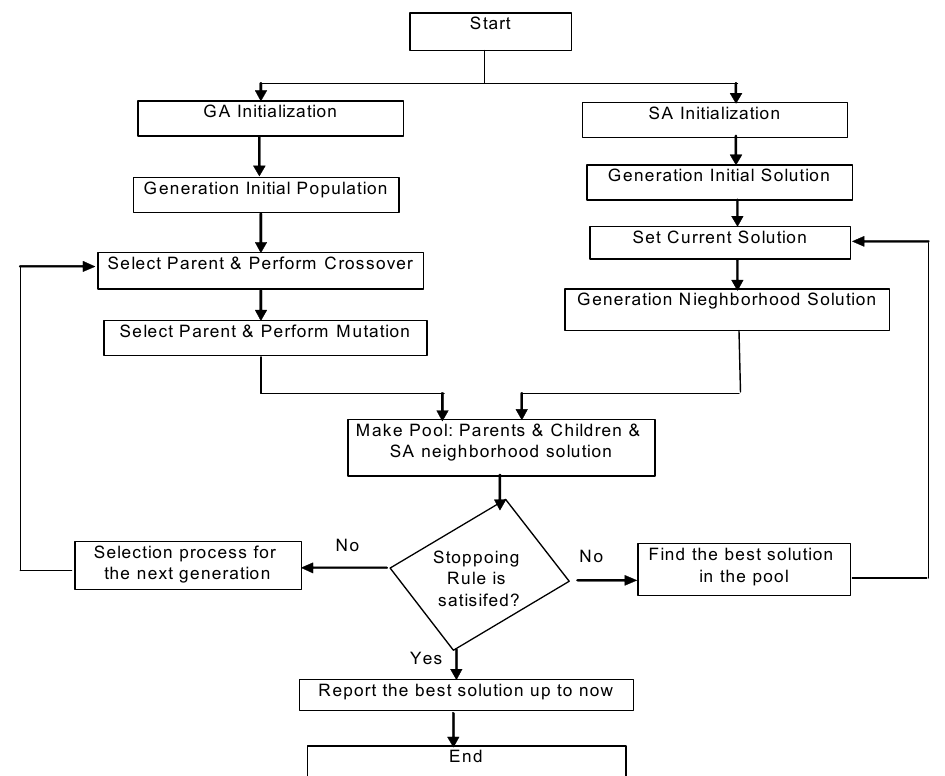
F IGURE 1. Conceptual framework of the proposed